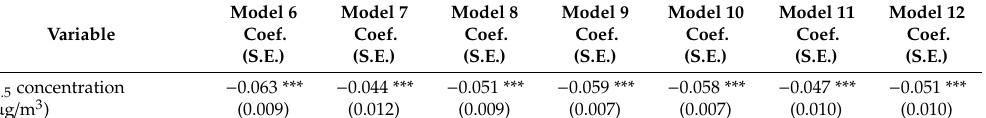
Model 12 Model 11 Model 9 Model 10 Model 8 Model 7 Model 6 Coef. Coef. Coef. Coef. Coef. Coef. Coef. (S.E.) (S.E.) (S.E.) (S.E.) (S.E.) (S.E.)